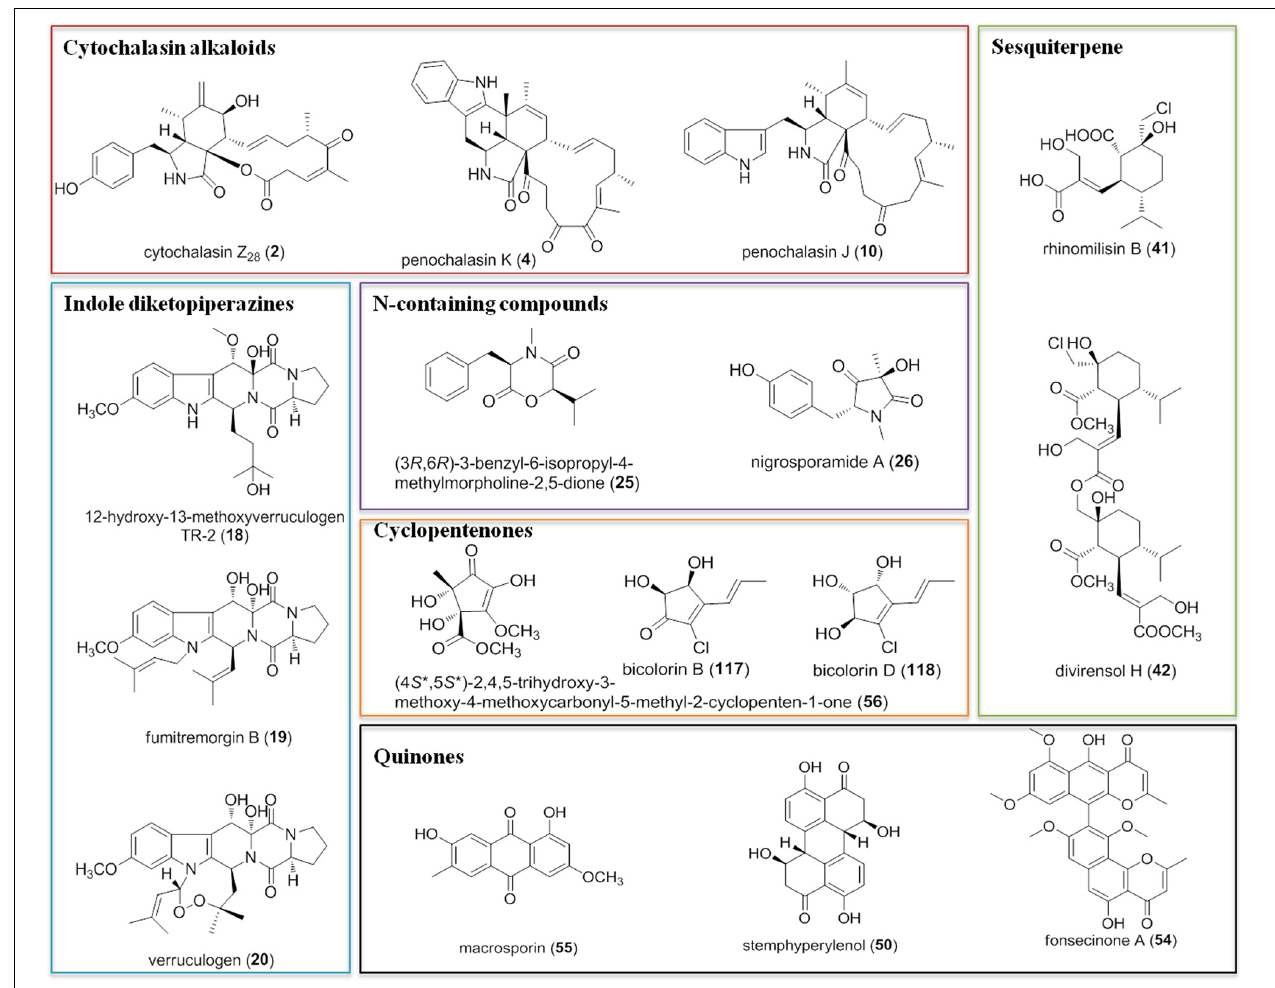
FIGURE 12 | Potential candidates of new natural